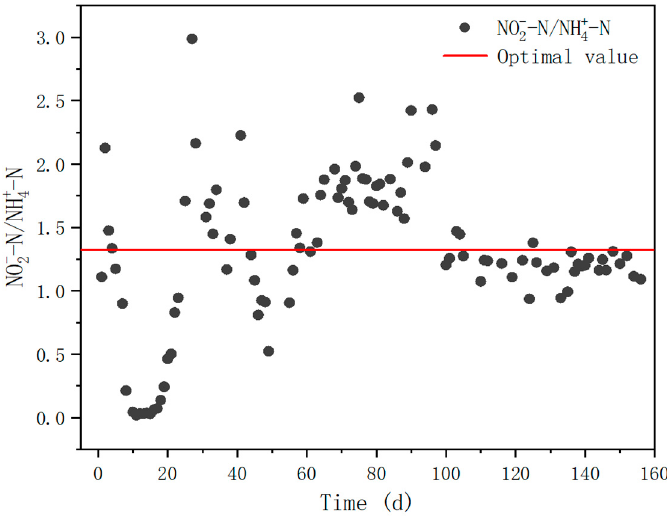
Figure 5. The concentration ratio of nitrite and ammonia in effluent.